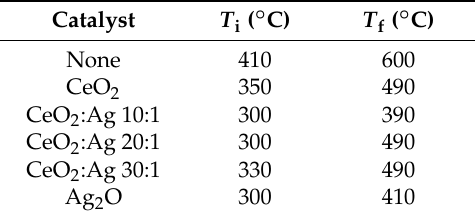
Table 4. Catalytic performance for soot oxidation.